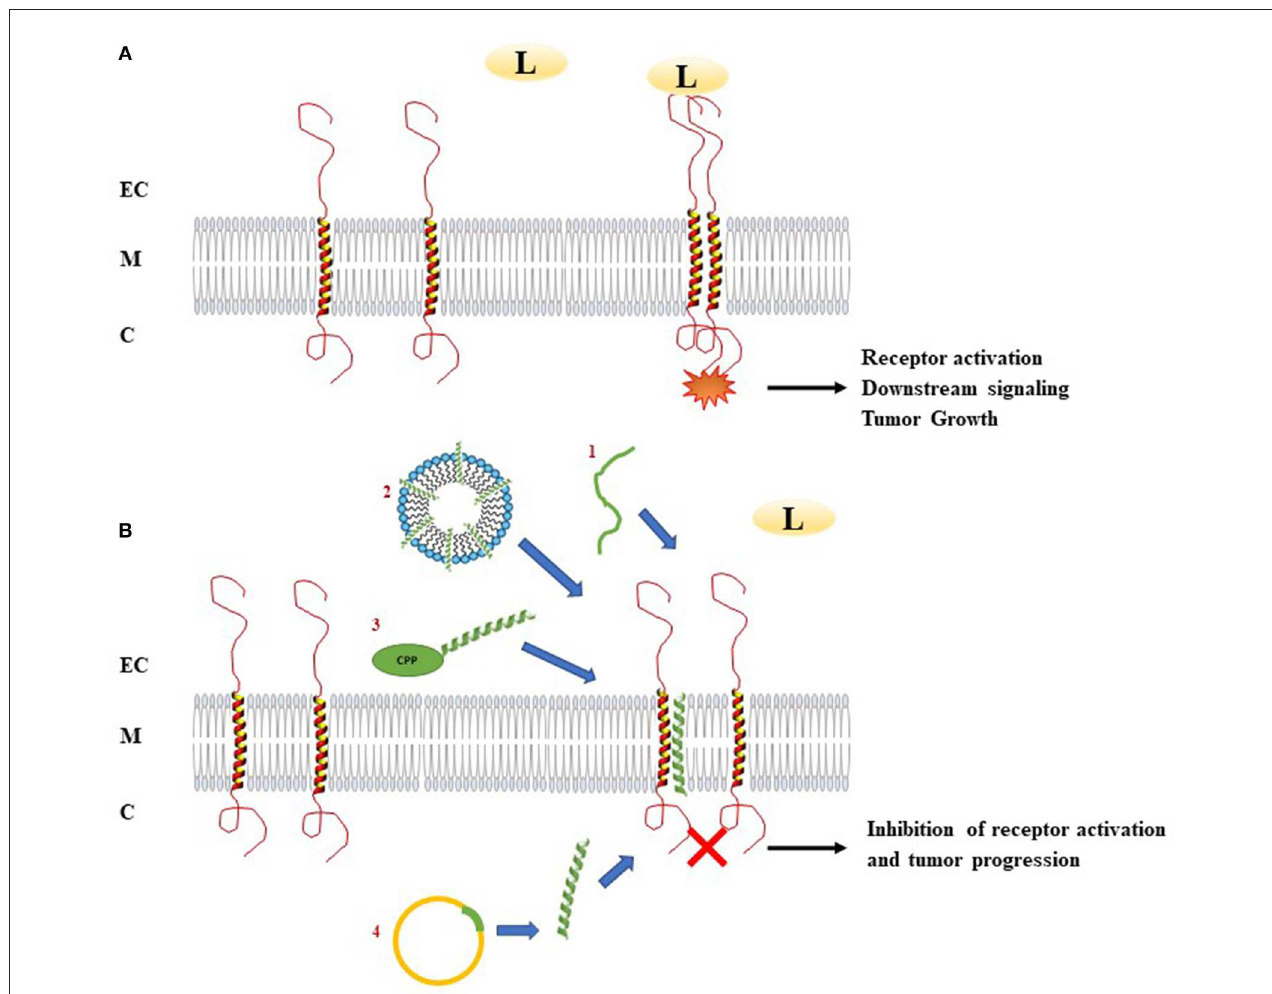
FIGURE 1 | Mechanism of action of transmembrane peptides to inhibit receptor dimerization. (A) Ligand binding induces dimerization and activation of receptors. This activation leads to downstream signaling activation. In the case of abnormal activation, receptor dimerization can be associated with pathological processes as tumor growth. (B) Introduction of TM hydrophobic peptides which mimic the TM segments of membrane proteins involved in cancers can disturb the dimerization of these receptors. In order to deliver TM peptides, several methods could be used: (1) acidity-Triggered Rational Membrane (ATRAM) peptide, (2) delivery of the peptide by detergent micelles, (3) delivery of the peptide using cell penetrating peptide, (4) plasmid encoding TM peptide. C, Cytoplasm; CPP, Cell penetrating peptide; EC, Extracellular environment; L, Ligand; M, Membrane; TM peptide, Transmembrane